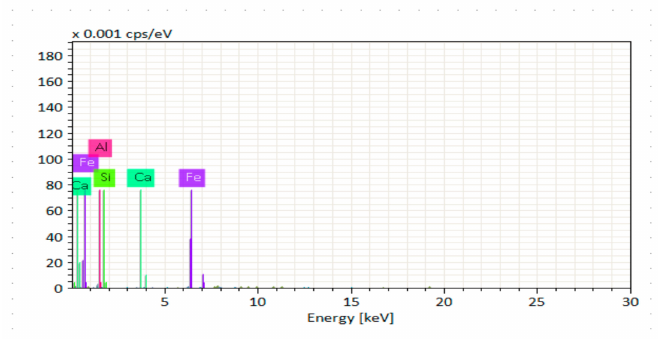
Figure 22. EDS graph of GPC-C0F mix specimen.